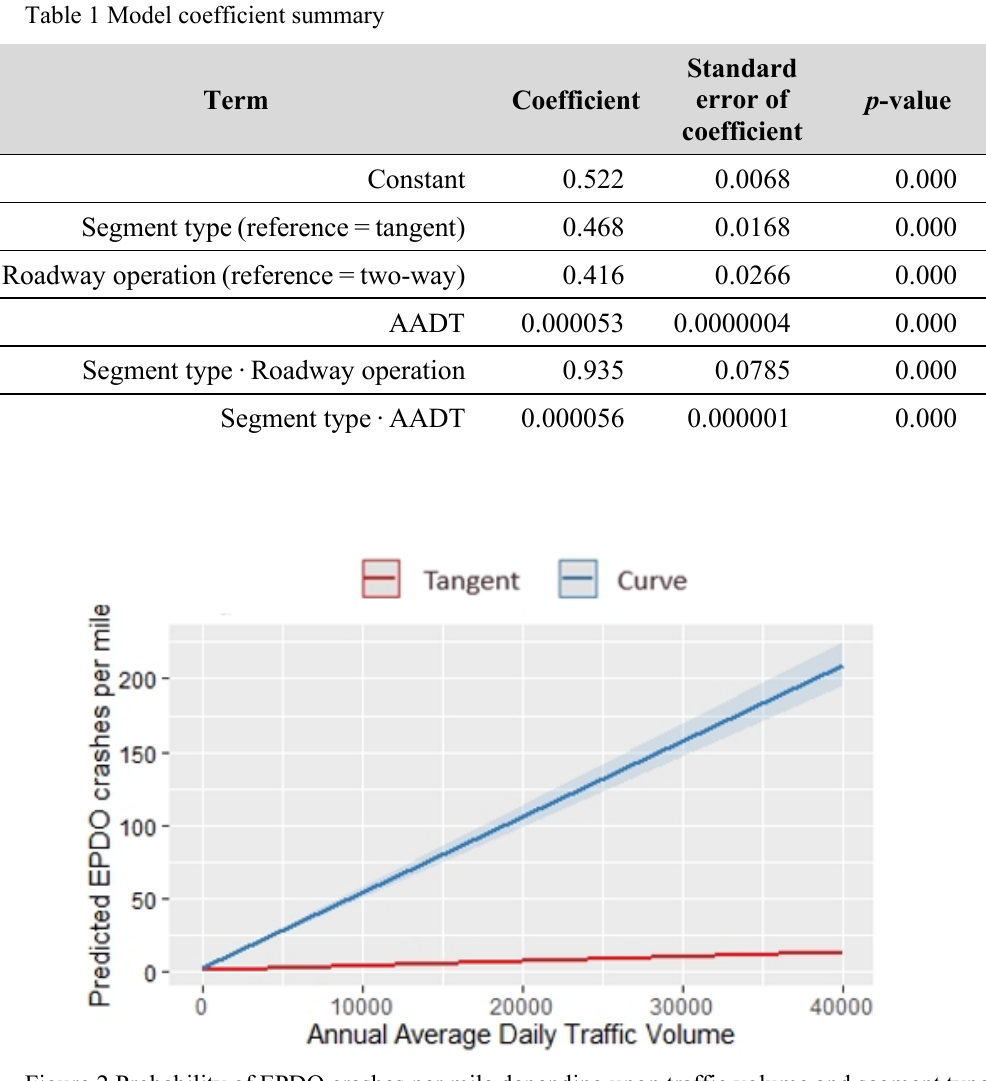
Figure 2 Probability of EPDO crashes per mile depending upon traffic volume and segment